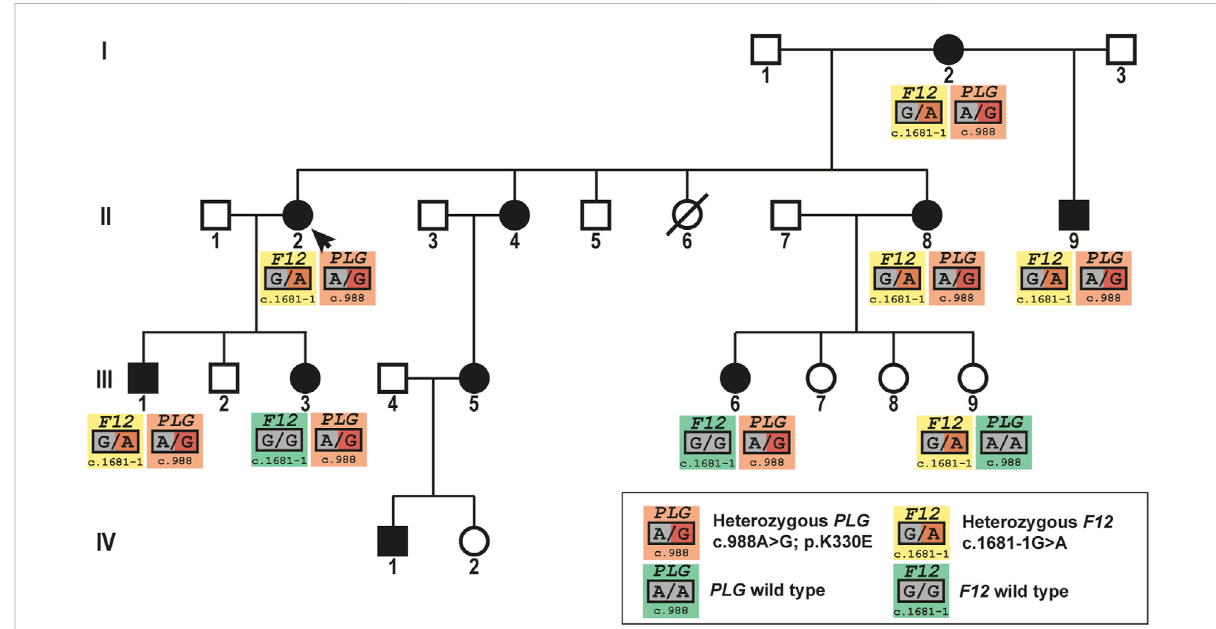
FIGURE 1 Pedigree of the large HAE-PLG family showing the inheritance of the HAE-causing PLG mutation c.988A > G; p.K330E and the F12 mutation c.1681-1G > A resulting in the loss of protein expression from the mutated